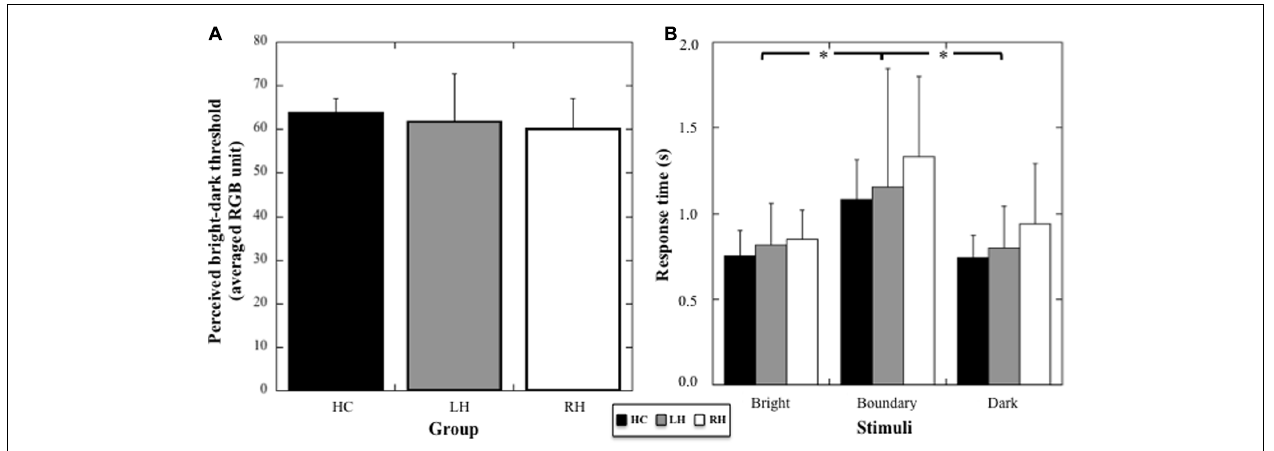
FIGURE 2 | (A) Mean threshold (and SD, in averaged RGB unit) in the color discrimination task for HC, RH, and LH groups. (B) Mean response times (and SD, in seconds) for the stimuli judged bright, dark, or at the boundary between bright and dark color. Stars indicate significant statistical difference.